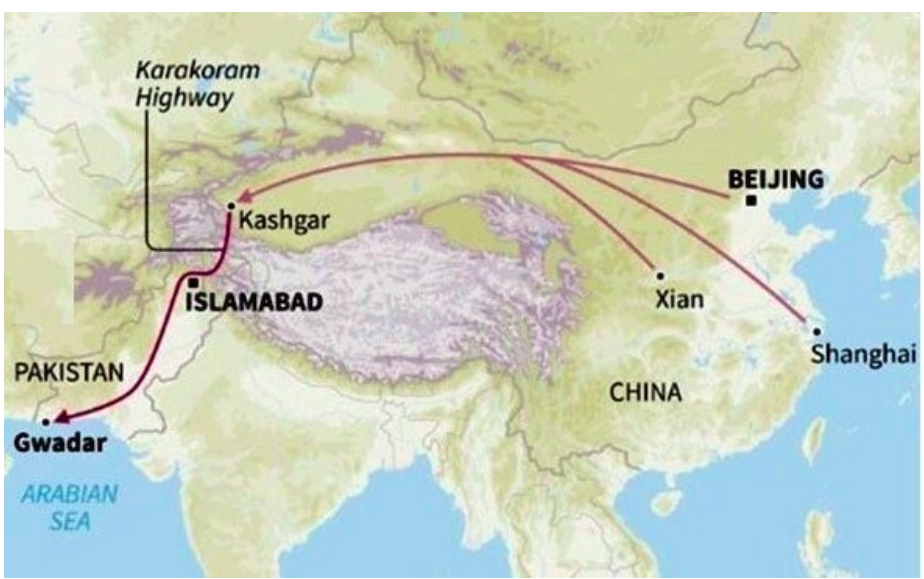
Figure 1: China-Pakistani economic corridor. One belt, one road project (OBOR) (Source: Daily DAWN